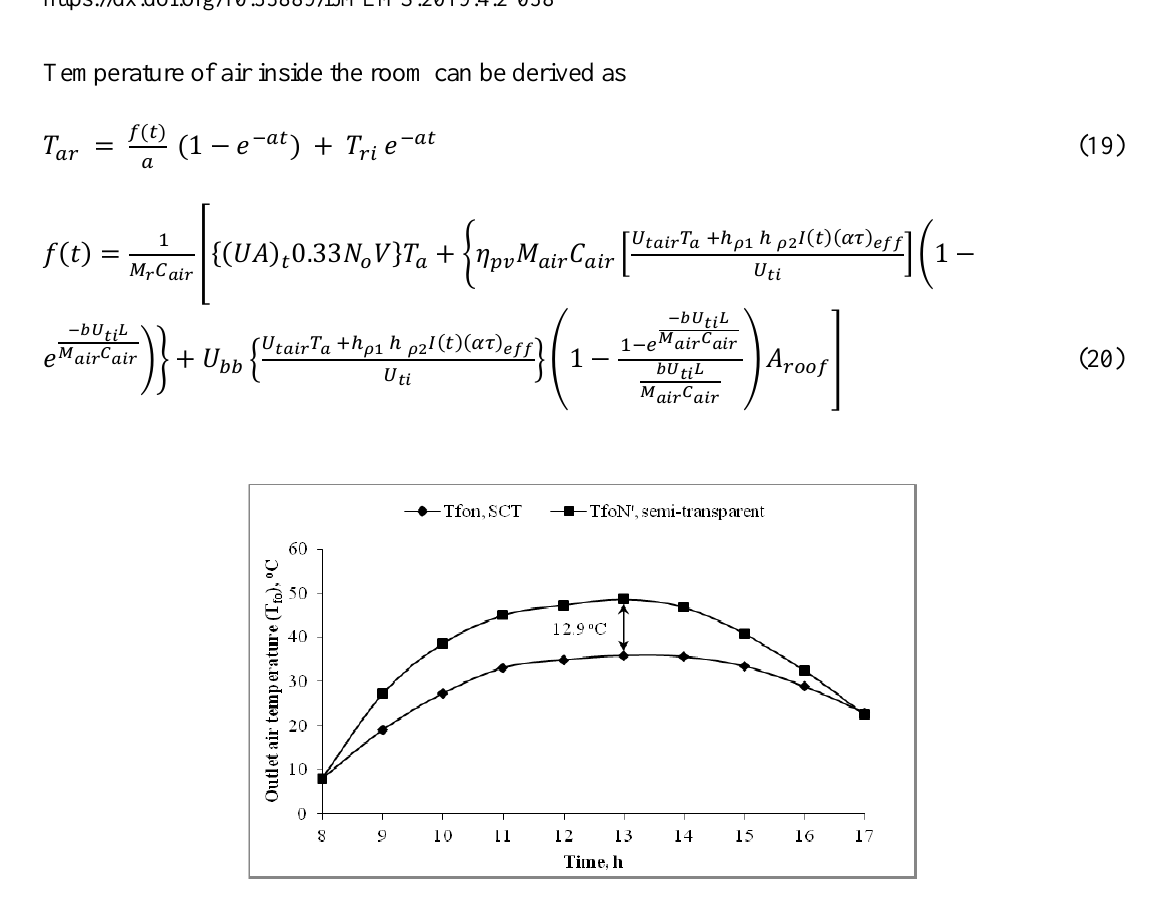
Figure 4. Variations of room air temperature w.r.t time